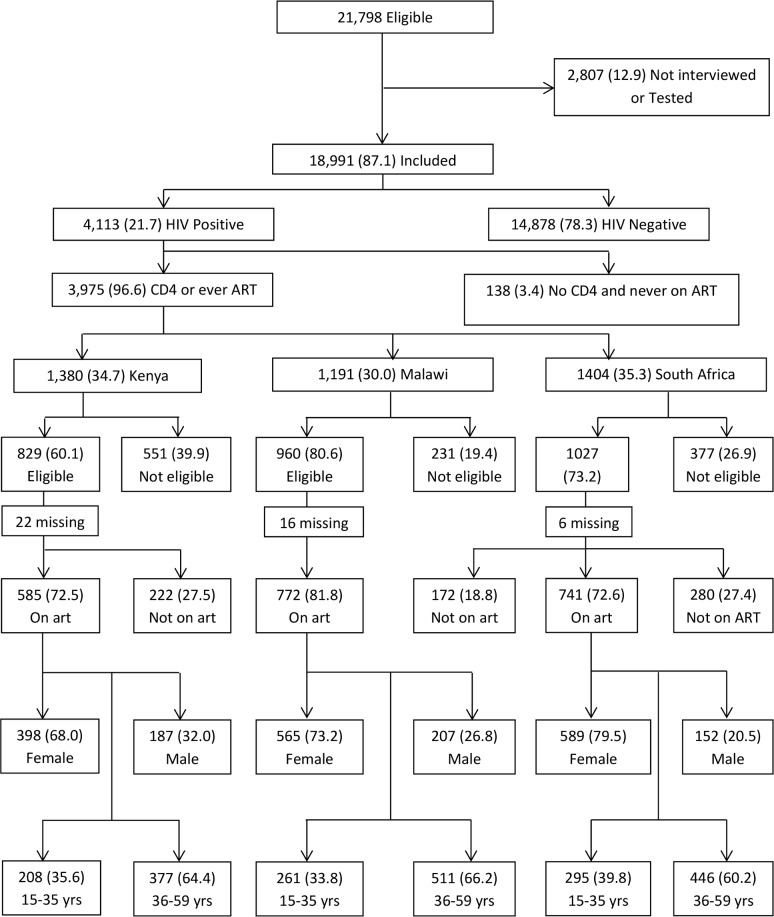
Flow chart showing individuals included in the survey.Distribution of individuals included in the survey by HIV status, country, ART eligibility at the time of the survey, ART status, sex and age.